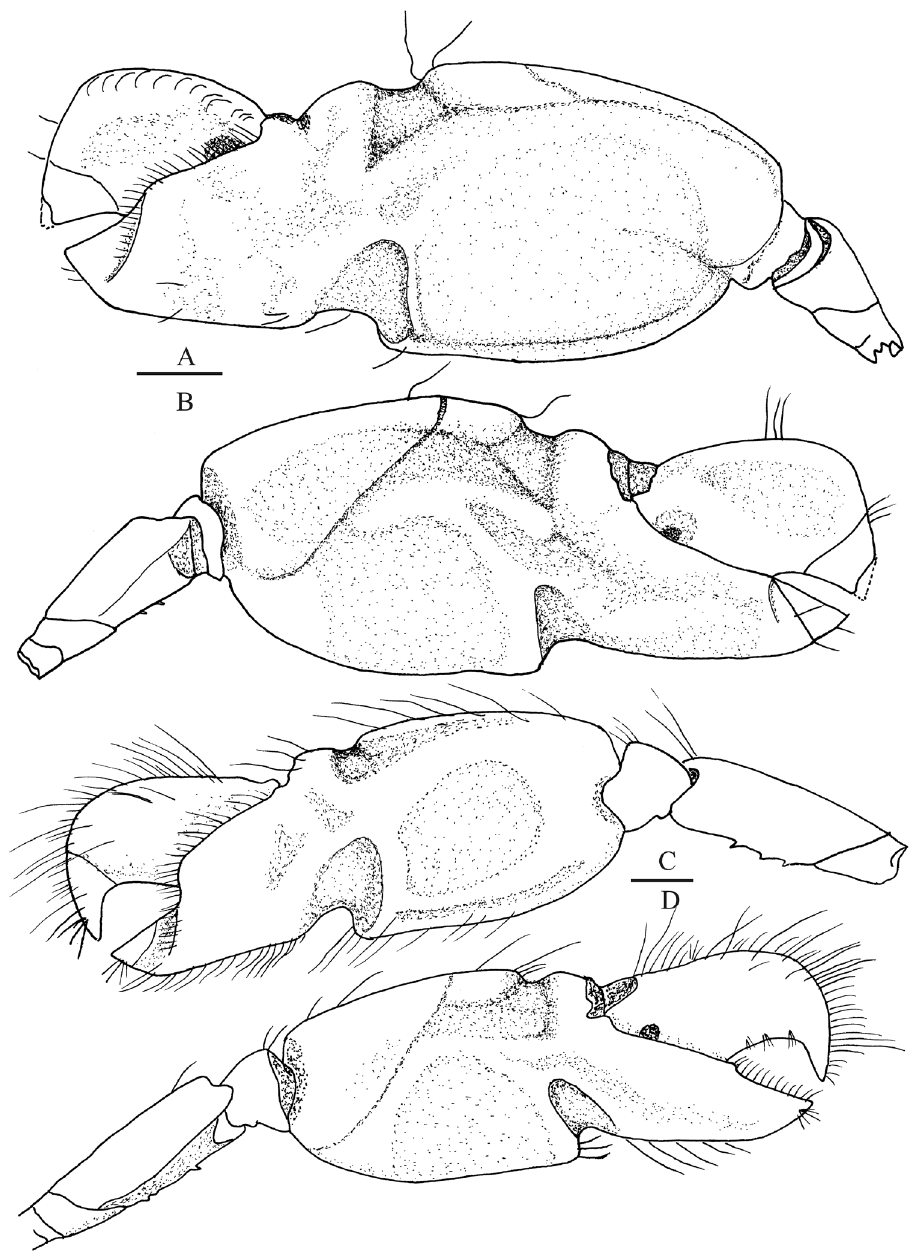
Figure 3. Alpheus margaritae sp. n. Female paratype, CL 7.4 mm ( A, B ) (EMU-10581); male paratype, CL 6.5 mm ( C, D ), (CNCR 32595); A, C major first pereopod, mesial view B, D same, lateral view. Scale bars 1